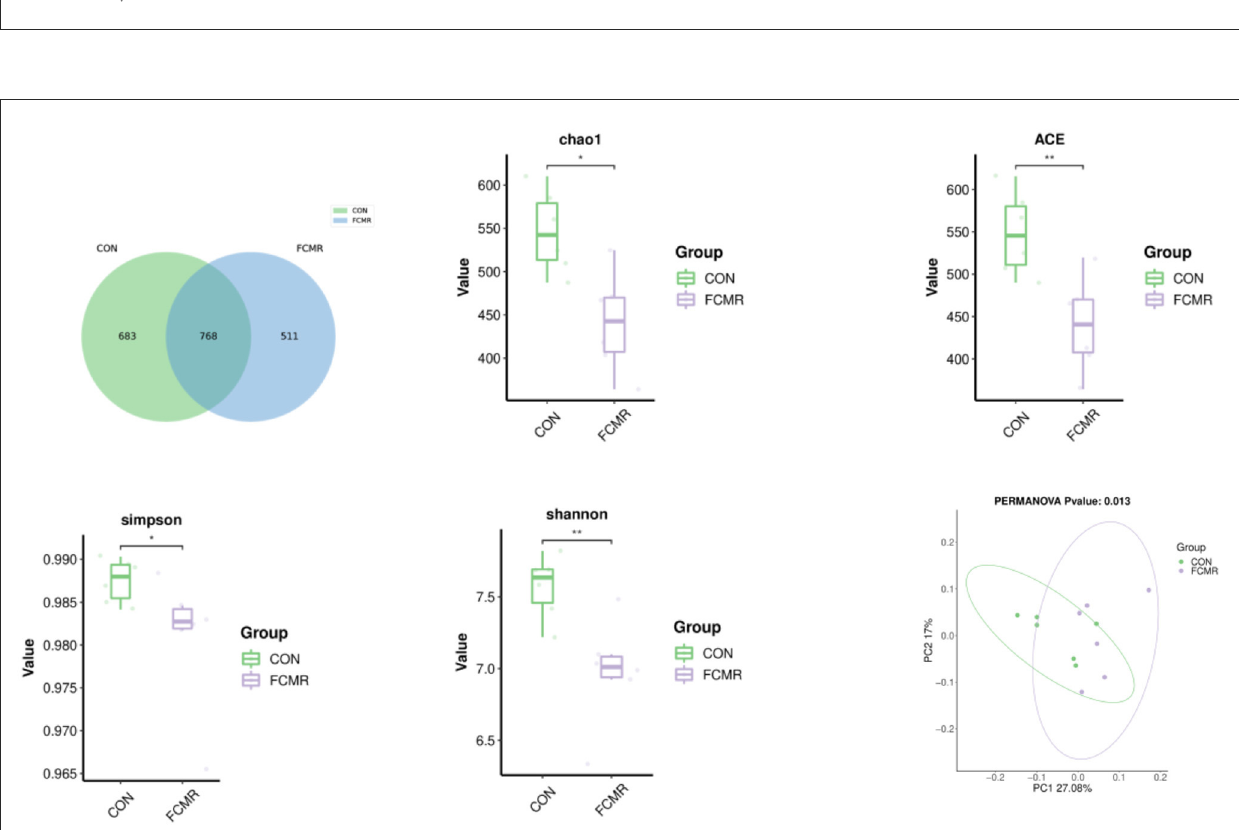
FIGURE2 The mRNA expression level of tight junction protein and immunomodulatory genes in broilers jejunum. *Represents a remarkable difference among the two groups ( n = 6, p < 0.05); ZO-1, zonula occluden-1; IL-1 β , interleukin-1 β ; IL-6, interleukin-6; TNF- α , tumor necrosis factor- α ; INF- γ , interferon- γ .